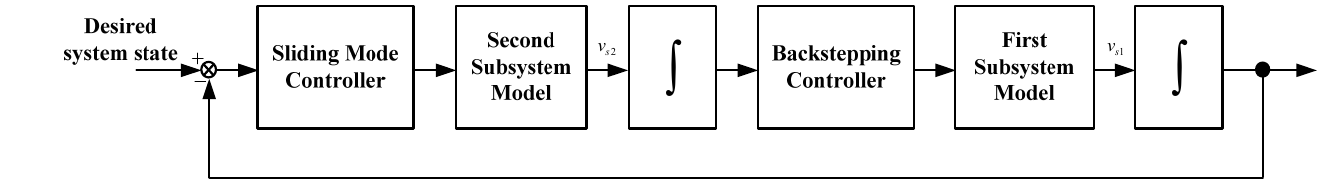
Figure 3. General form of IB-SMC reflecting dynamics of quadrotor.